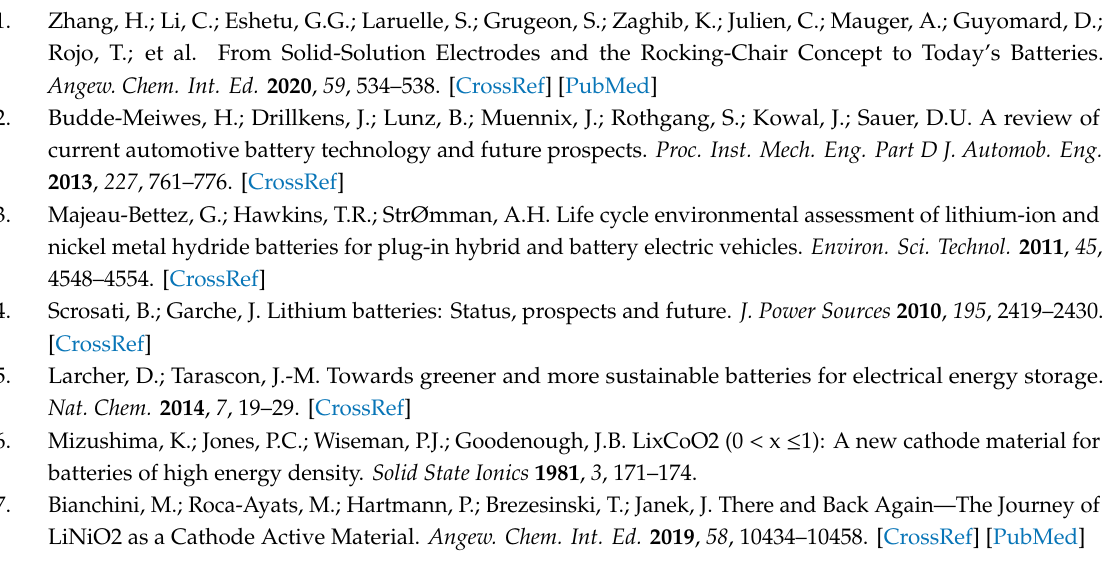
LCO estimated for all structures; Figure S2: PDOS of LCO compound for mC8 and oP8 structures. Upper panel monoclinic electronic structure of LCO (mC8) and bottom panel orthorhombic electronic structure of LCO (oP8). Color Code: Li green, Co blue, O red. Figure S3: PDOS of LNO compound for hR12 and oP8 structures. Upper panel rhombohedral electronic structure of LNO (hR12) and bottom panel orthorhombic electronic structure of LNO (oP8). Figure S4: PDOS of LMO compound for hR12 and mC8 structures. Upper panel rhombohedral electronic structure of LMO (hR12) and bottom panel monoclinic electronic structure of LMO (mC8). Figure S5: (a) Dingle unit cell of TMs oxide, CoO, NiO and MnO that present cubic structures belonging to Fm 3 m space group. (b) AFM structure of TMs oxide, that are made of alternatively packed ferromagnetic (111) planes along the [1 · 1 · 1] direction of the cubic cell. Color code: (a) blue Co, grey Ni, purple Mn, red O; (b) spin up blue, spin down light blue. Figure S6: (a) α -Mn 2 O 3 2 × 2 × 2 supercell. (b) AFM structure of TM oxide. Color code: (a) purple Mn, red O; (b) spin up blue, spin down light blue. Figure S7: Cubic structure of (a) Li 2 O and (b) Li. Color Code: green Li, red O. Table S1. Calculated bond lengths for LCO [45], LNO [46,47] and LMO [37,48] for all lattices; inter parentheses are reported the corresponding values from experimental structures, where available. Table S2: Computed Cohesion energies (eV / at) for all ground state lattice / phase. Table S2: Energies of formation form the elements at T = 298 K, TMs oxide and Li 2 O [5,6] Table S3: Calculated Energy of formation at 0K from elements for all the polymorphs (hR12, mC8 and oP8) of the LCO, LMO and LNO compounds. Table S4: Experimental and estimated absolute entropies at 298K and thermal e ff ects at 298 K for the LCO, LMO and LNO